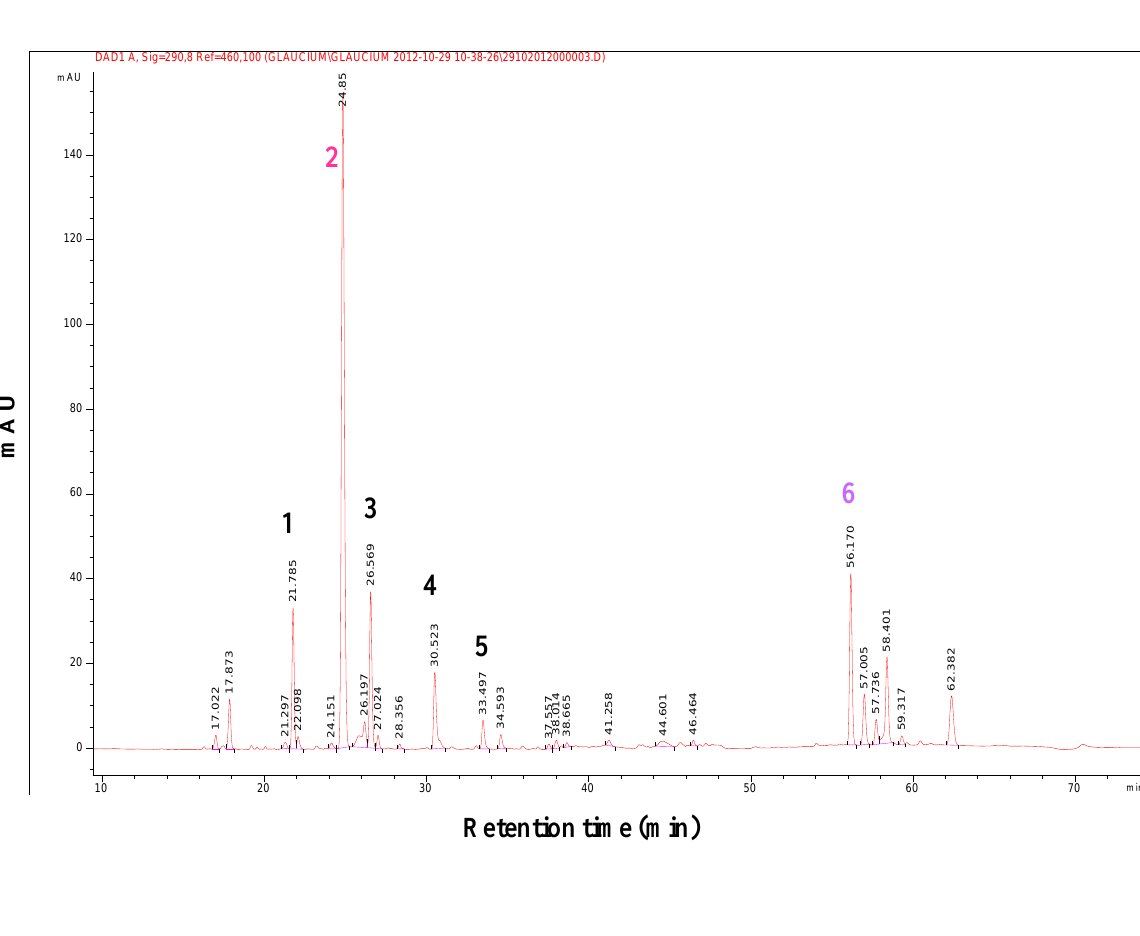
Figure 1. HPLC-DAD of alkaloidic extract ( A ) and methanolic extraction of the dry powder ( B ) of root of G . flavum at diode array UV-detection (λ = 290 nm). Peak identification: ( 1 ) magnoflorine, ( 2 ) protopine as major compound, ( 3 ) chelidonine, ( 4 ) sanguinarine, ( 5 ) chelerythrine, ( 6 )